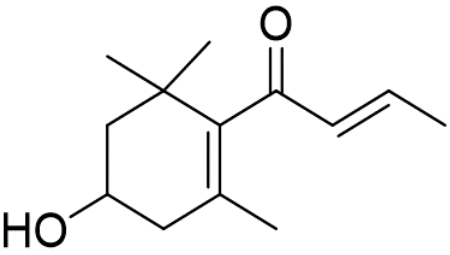
Figure 1. Structure of 3-hydroxy- β -ionone .